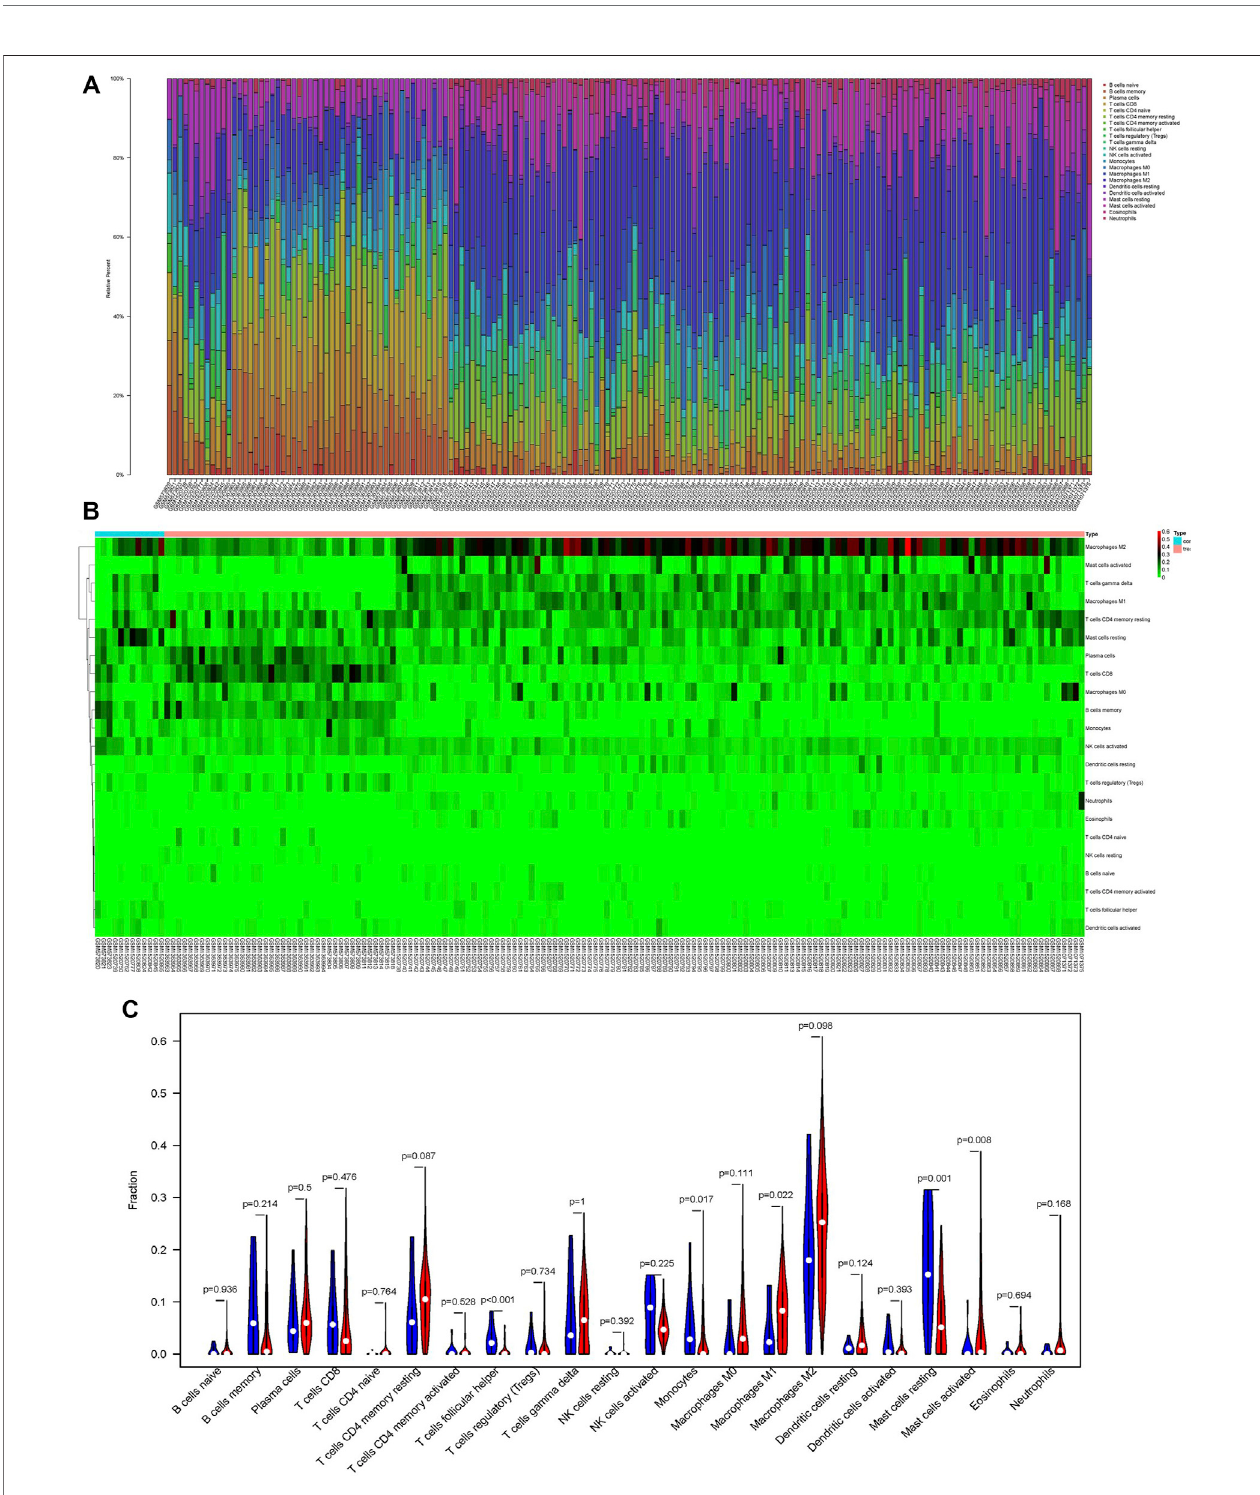
FIGURE 10 | Proportion of the 22 immune cells detected by the CIBERSORT algorithm (A,B) . Results of the Wilcoxon rank-sum test (C) . Proportions of follicular helper T cells ( p < 0.001), monocytes ( p = 0.017), M1 macrophages ( p = 0.022), resting mast cells ( p = 0.001), and activated mast cells ( p = 0.008) were signi fi cantly different between pancreatic cancer samples and normal pancreatic samples.